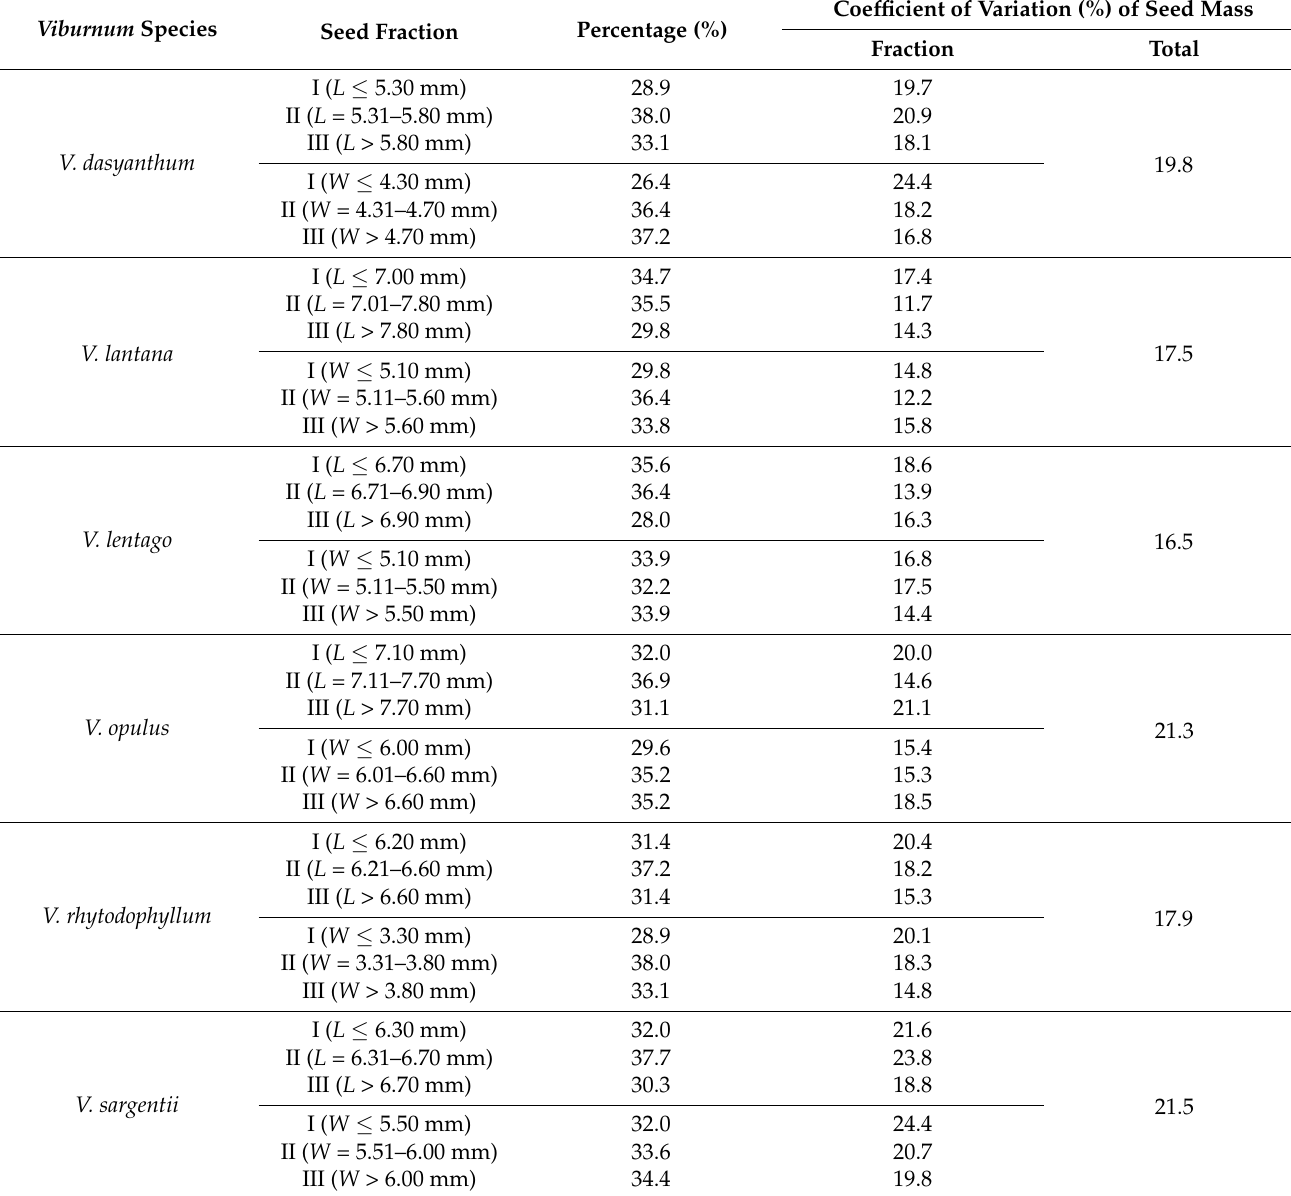
Table 5. Coefficient of variation of seed mass in three seed